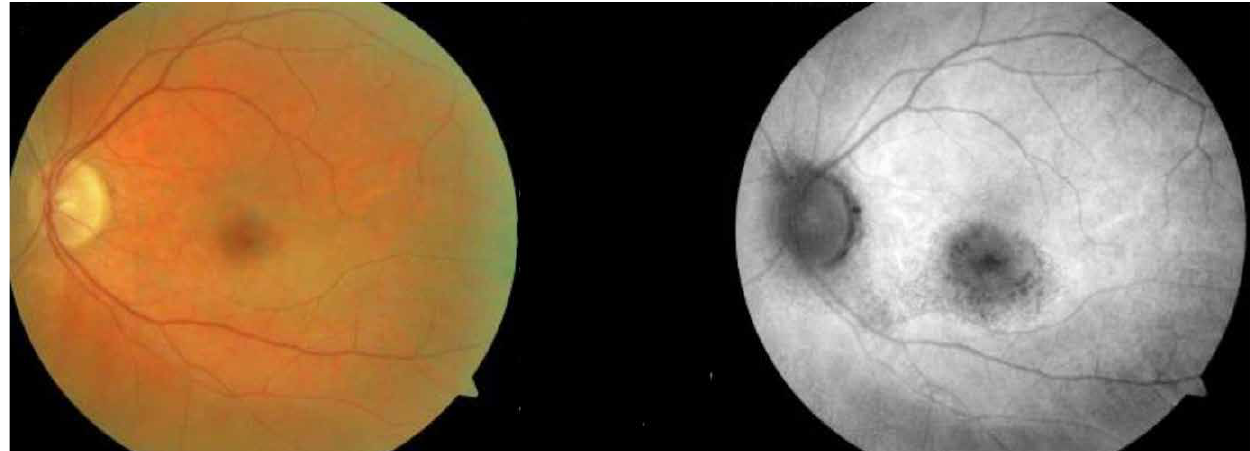
Figure 4: Chloroquine / hydroxychloroquine retinopathy. Retinal pigment epithelium abnormalities develop with long-term CQ/ HCQ intake. The abnormalities begin with a fine pericentral ring of increased autofluorescence which later widens. Firstly a mottled and then a general loss of the retinal pigment epithelium can be seen due to an absence of autofluorescence as shown in the above example. (Photograph courtesy of Dr Peter